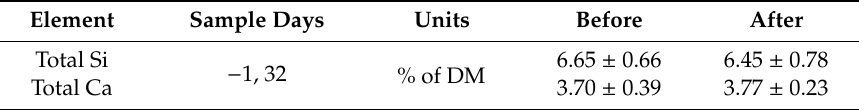
Table 3. Total Si and Ca levels in the soil before and after the experimental period. Element Sample Days Units